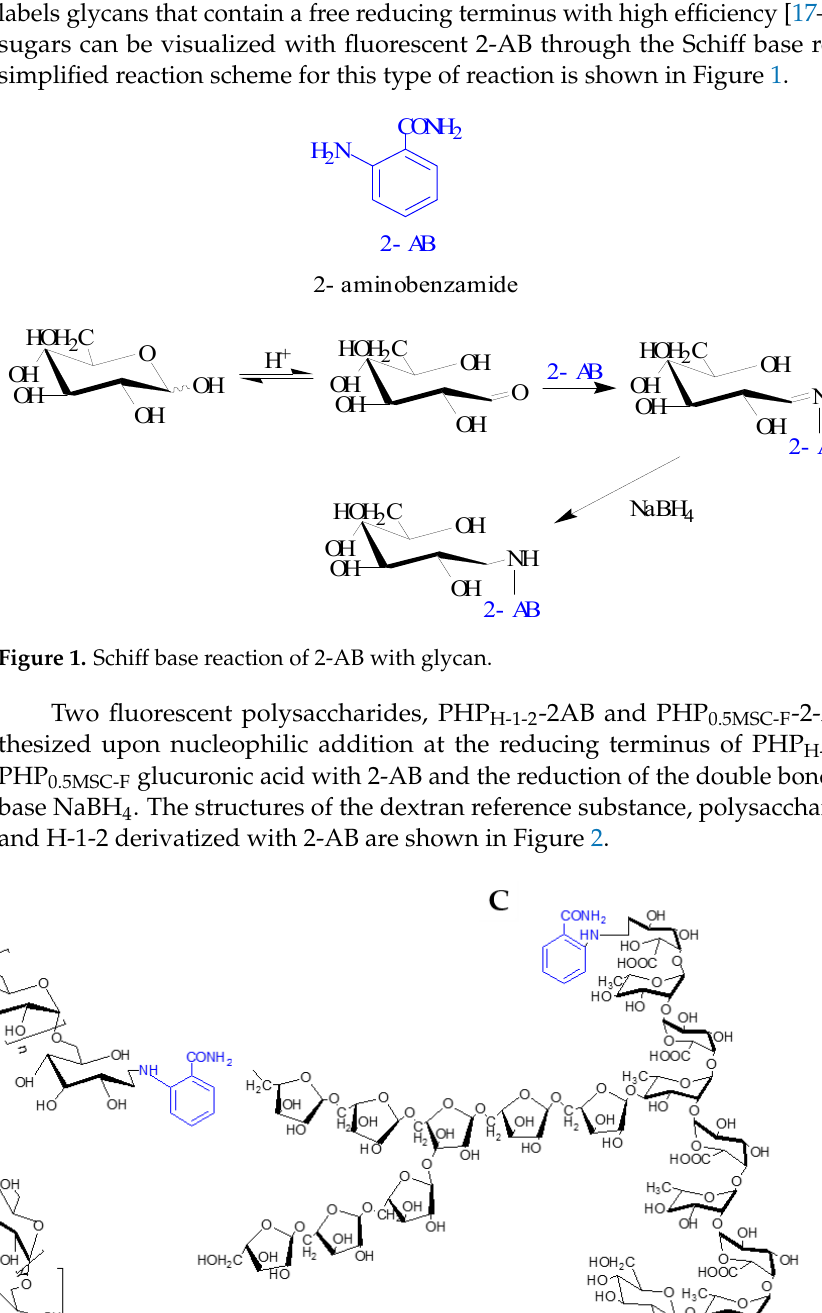
Figure 2. Structures of derivatized fluorescent polysaccharides. Blue highlights the structure of 2-AB in the figure. Dextran derivatives with 2-AB ( A ), PHP H-1-2 -2AB ( B ), and PHP 0.5MSC-F -2-AB ( C ) are